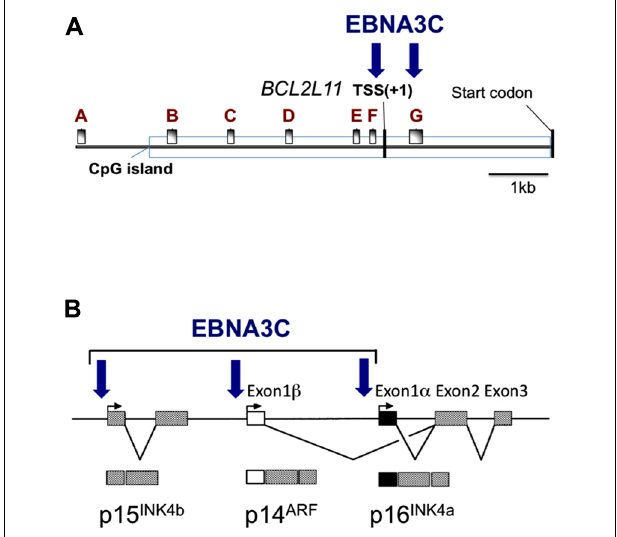
FIGURE 2 | Epitope-tagged EBNA3C associates with the promoter for BIM and genes in the INK4b-ARF-INK4a locus. Schematic representations of (A) approximately 9kb of the BCL2L11 (BIM) promoter and (B) approximately 40 kb including the INK4b-ARF-INK4a locus.Vertical arrows indicate the positions where EBNA3C has been detected by chromatin immunoprecipitation (ChIP) analyses using lymphoblastoid cell lines (LCL) established using EBV expressing an epitope-tagged EBNA3C. These same regions of chromatin are marked by the polycomb (PRC2)-mediated modification H3K27me3 when EBNA3A and EBNA3C are present (adapted from Paschos etal., 2012; Skalska etal., 2013).The BCL2L11 gene transcriptional start site (TSS) and the protein products of INK4b-ARF-INK4a are indicated . A–G in (A) mark the positions of RT-PCR primer sets used in (Paschos etal.,